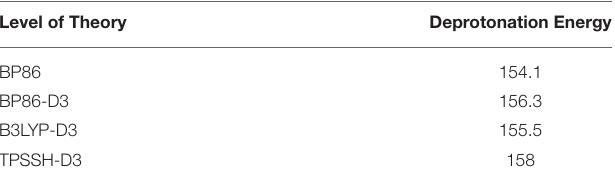
TABLE 3 | Calculated deprotonation energies of R509 of E. coli Hyd-1 using QM/MM calculations in